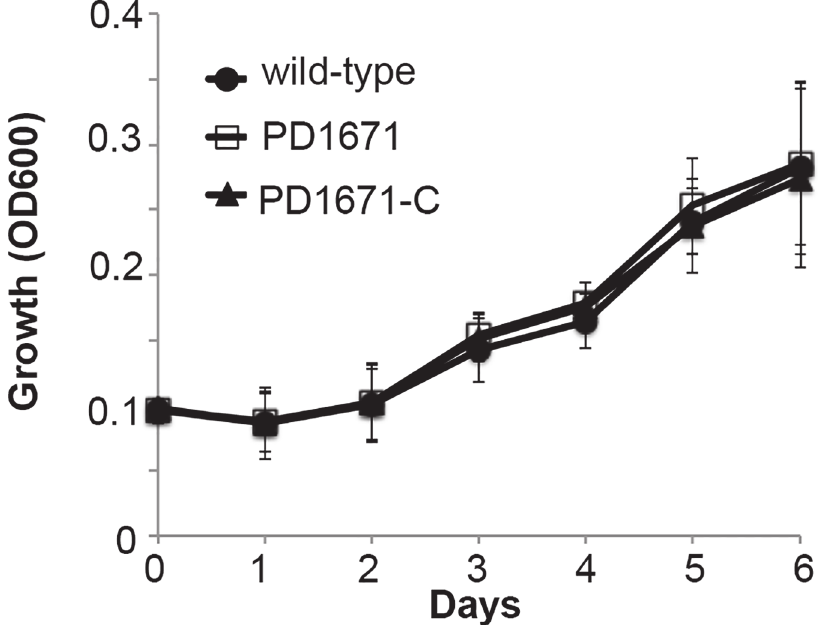
Fig 2. Growth curve of the X . fastidiosa PD1671 mutant. Growth of wild-type X . fastidiosa Temecula 1 (circle), PD1671 mutant (square), and complemented PD1671 mutant (PD1671-C) (triangle) strains in Vitis vinifera Chardonnay xylem sap. Cell densities were measured daily at OD 600 . Average and standard deviation of the averages of five independent experiments with a minimum of four replicates each ( P =